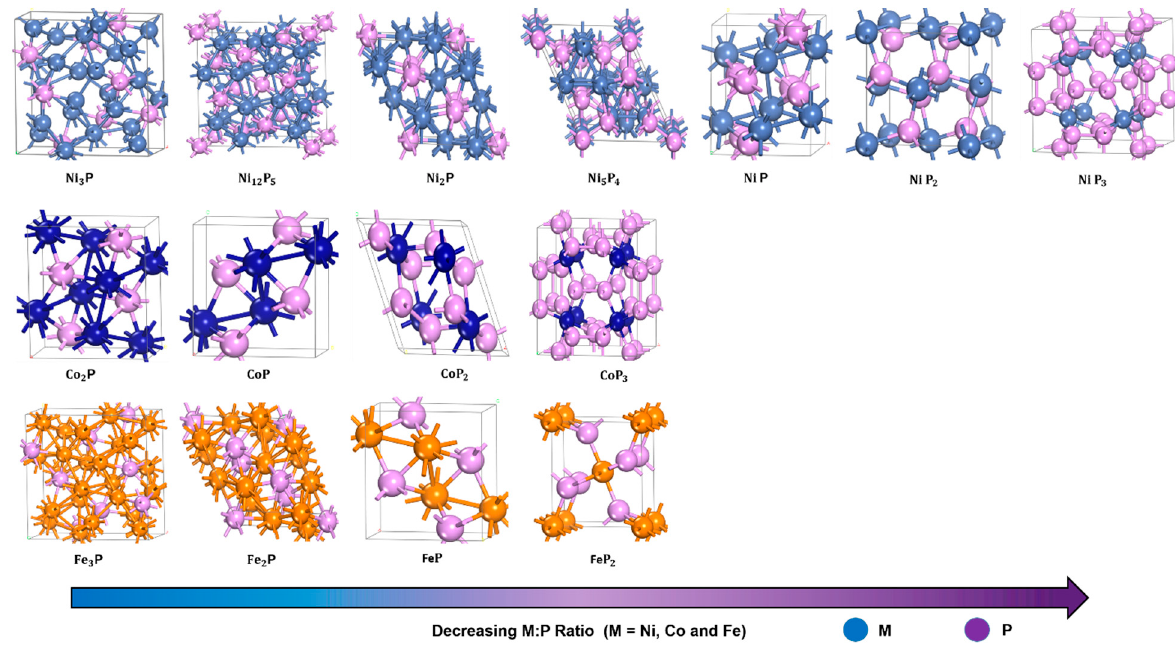
Figure 3. Versatility of Crystal Structures of TMPs. Table 1. Categorization of metal phosphides.